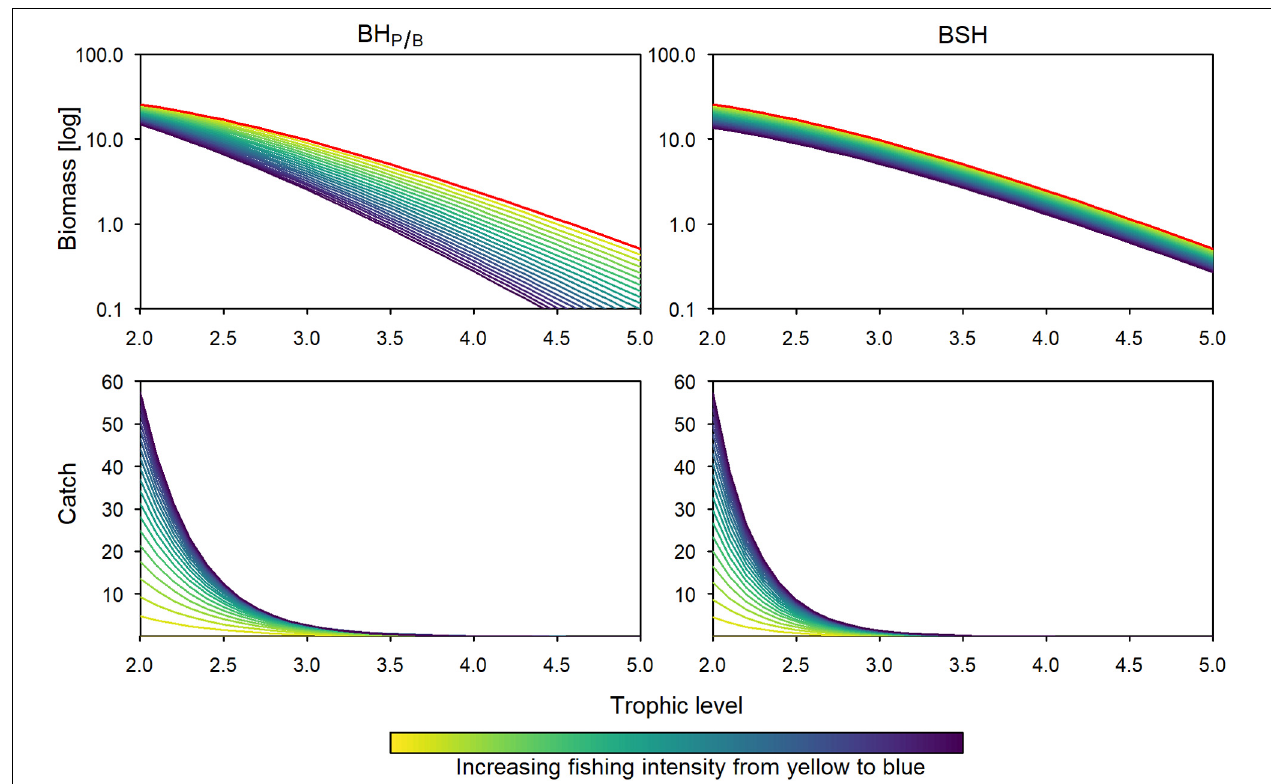
FIGURE 3 | Biomass (log transformed) and catch trophic structure using a BH P / B ( left panels) and a BSH ( right panels) fishing pattern. Colored lines depict different effort multipliers (increasing from yellow to blue). The red lines in the biomass trophic spectrum represent a multiplier of 0 (virgin